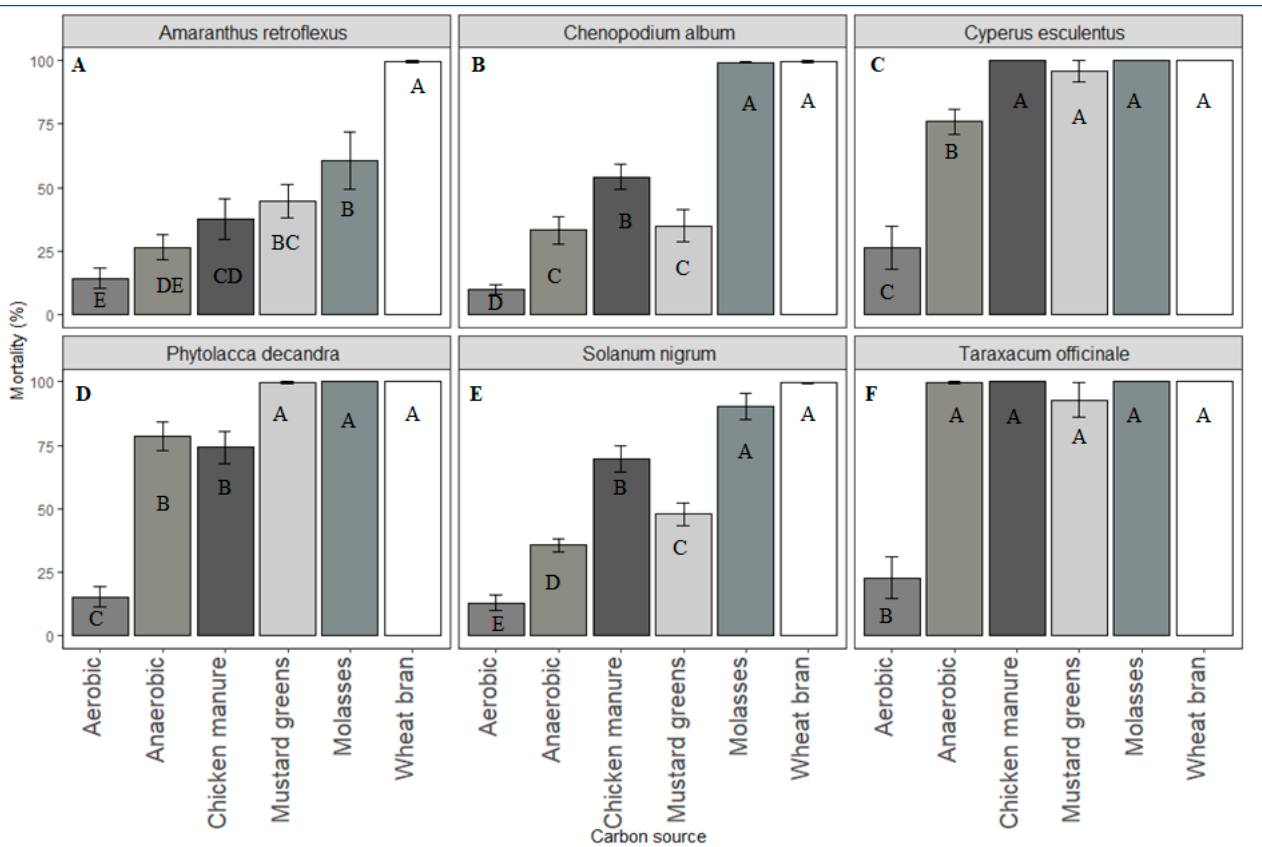
Figure 1. Effect of anaerobic soil disinfestation (ASD) with different carbon sources on seed mortality of ( A ). redroot pigweed ( Amaranthus retroflexus ), ( B ). common lambsquarters ( Chenopodium album ), ( C ). yellow nutsedge ( Cyperus esculentus ), ( D ). common pokeweed ( Phytolacca decandra ) , ( E ). black nightshade ( Solanum nigrum ) and ( F ). dandelion ( Taraxacum officinale ) under growth chamber conditions. Means followed by different letters are significantly different at p -value < 0.05 according to Fisher’s LSD test after square root transformation. Data presented are combined from two independent experiments each with three replications. Error bars indicates the standard error. Table 3. Inhibition of germination of resident weed seeds in soil collected from Badger Farm, OSU CFAES Wooster Campus, Wooster, OH by anaerobic soil disinfestation (ASD) with different carbon sources under growth chamber conditions.